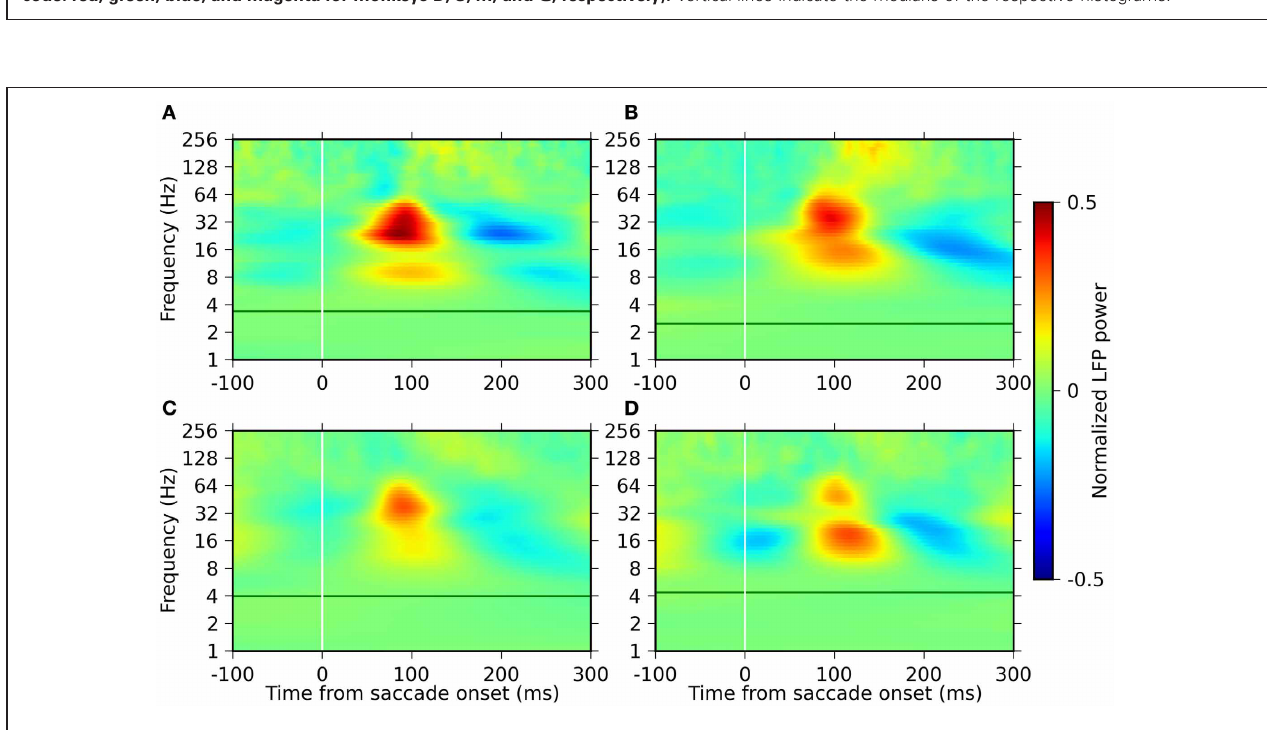
subtractionanddivisionbythestandarddeviation)separatelyforeachfrequency and plotted in pseudo-color code indicated by the color bar on the right. The greenhorizontal linesindicatethesaccadefrequency